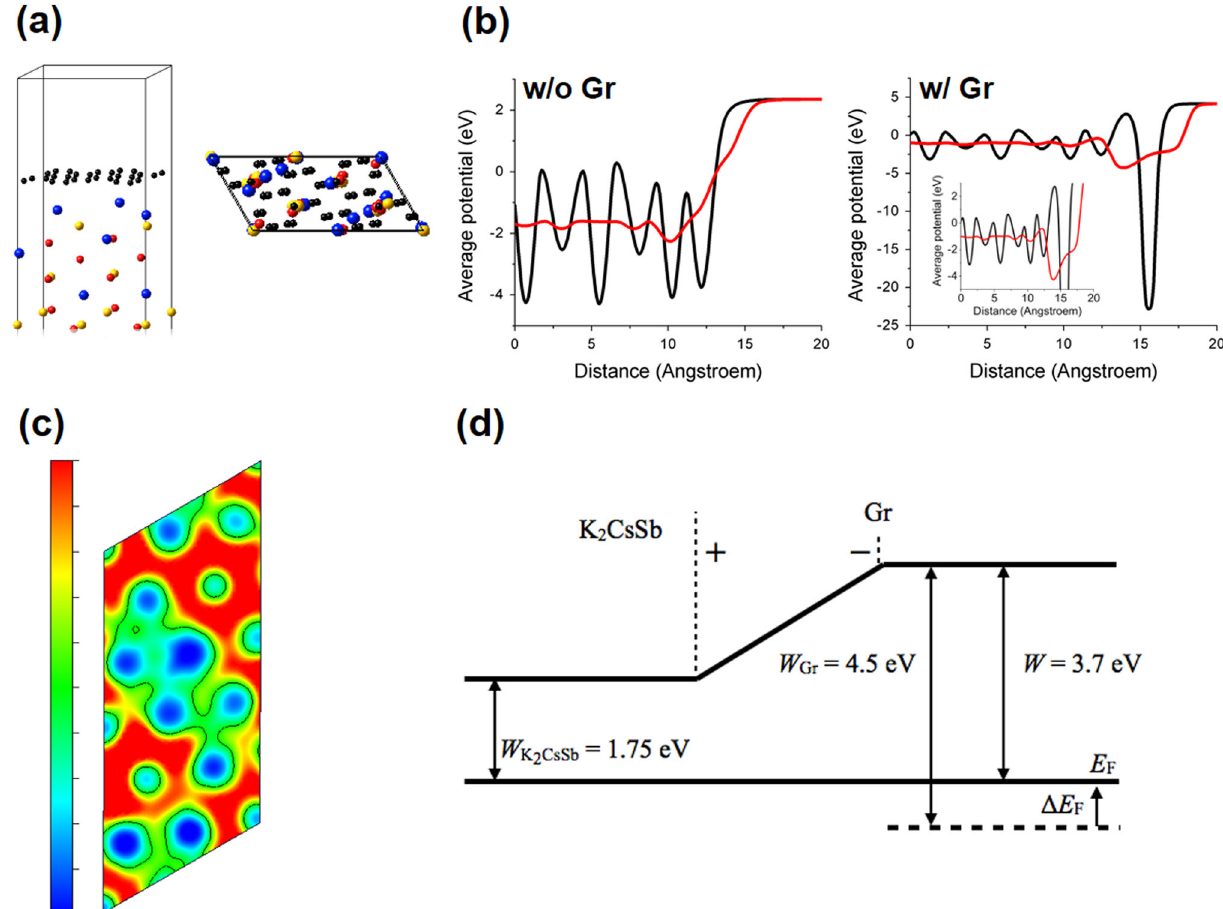
Fig. 5 a Unit cell of graphene on K 2 CsSb, with C, Cs, K, Sb atoms shown as black , blue , red and yellow , respectively. Views are shown along [111] direction ( left ) and (111) planes ( right ). b The local electrostatic potential without ( left ) and with ( right ) graphene on the surface of K 2 CsSb. All curves are averaged over the directions transverse to the surface normal. The red curve shows a suitable macroscopic average over approximately 5 Å to demonstrate the energy zero level, relative to vacuum. Inset is enlarged. c Direction of dipole at graphene-K 2 CsSb interface. Blue and red regions indicate electrons are being lost and gained, respectively. Speci fi cally, electrons are being lost from the Cs atoms (regions indicated by black circular lines ), and are gained by the C atoms ( red honeycomb regions ). d Band diagram at graphene-K 2 CsSb interface with inputs from b and